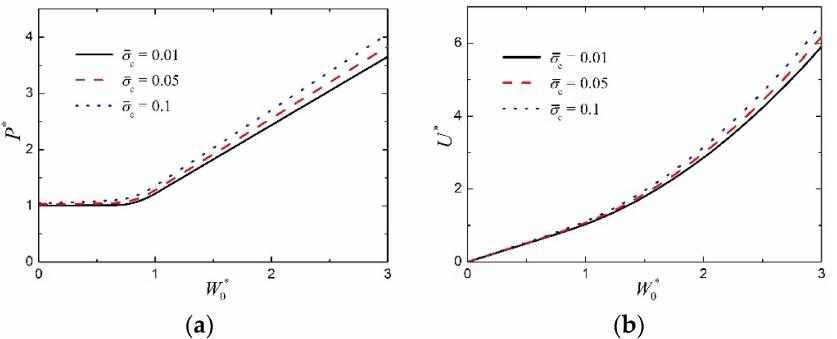
Figure 9. Influence of core strength on the large deflection response of FML sandwich beams transversely loaded by a flat punch ( c = 0.03, a = 0.05, h f = 0.05, n = 3, q = 2, f = 0.6): ( a ) Load versus midspan deflection; ( b ) absorbed energy versus midspan deflection.